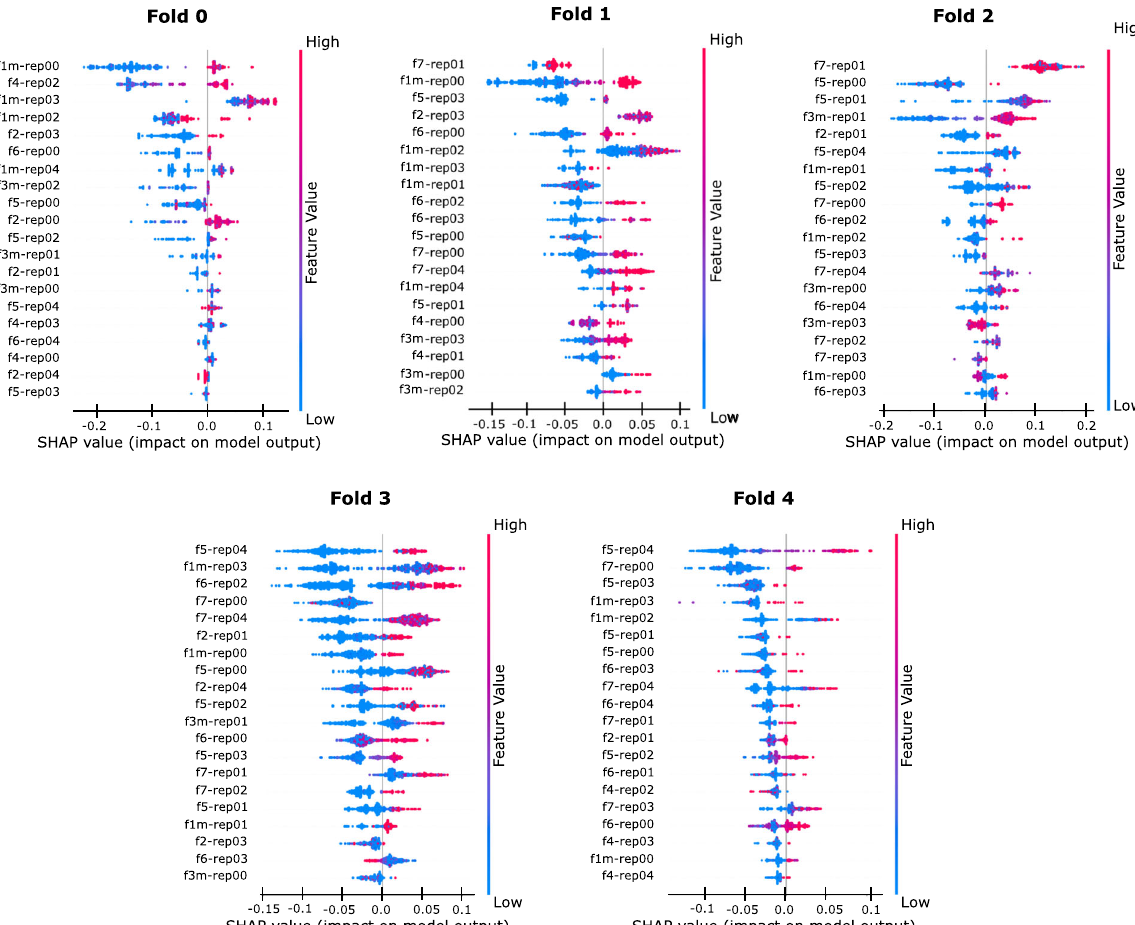
The correct version of Fig. 3 appears